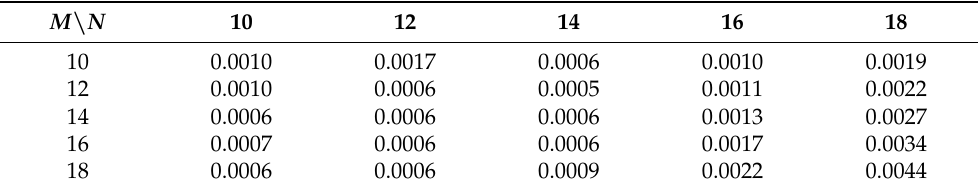
Table 3. Newton errors of the last iteration for u x obtained with Legendre collocation with different meshes ( N denotes the number of horizontal collocation points and M denotes the number of vertical collocation points); Ra = 5000, Γ = 3.495, np = 8, and mp = 2. M \ N 10